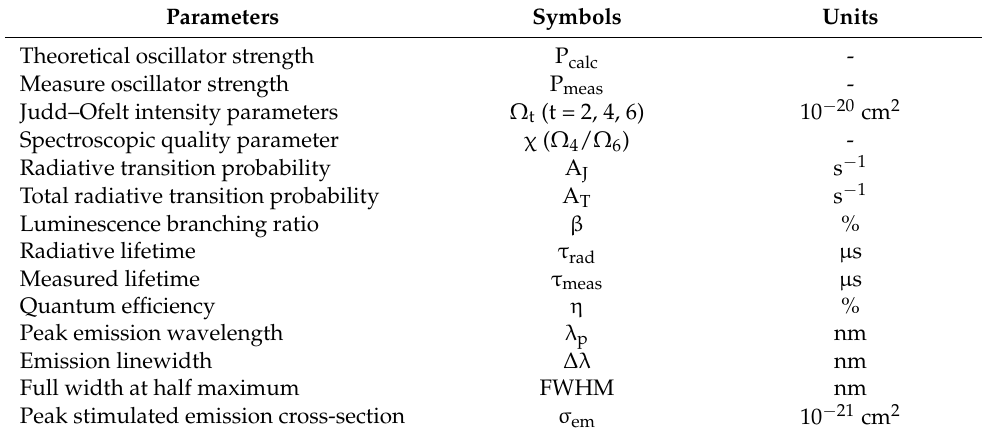
Table 2. Theoretical and experimental spectroscopic parameters for Dy 3+ in borogermanate glasses. Parameters Symbols Units Theoretical oscillator strength P calc - Measure oscillator strength P meas